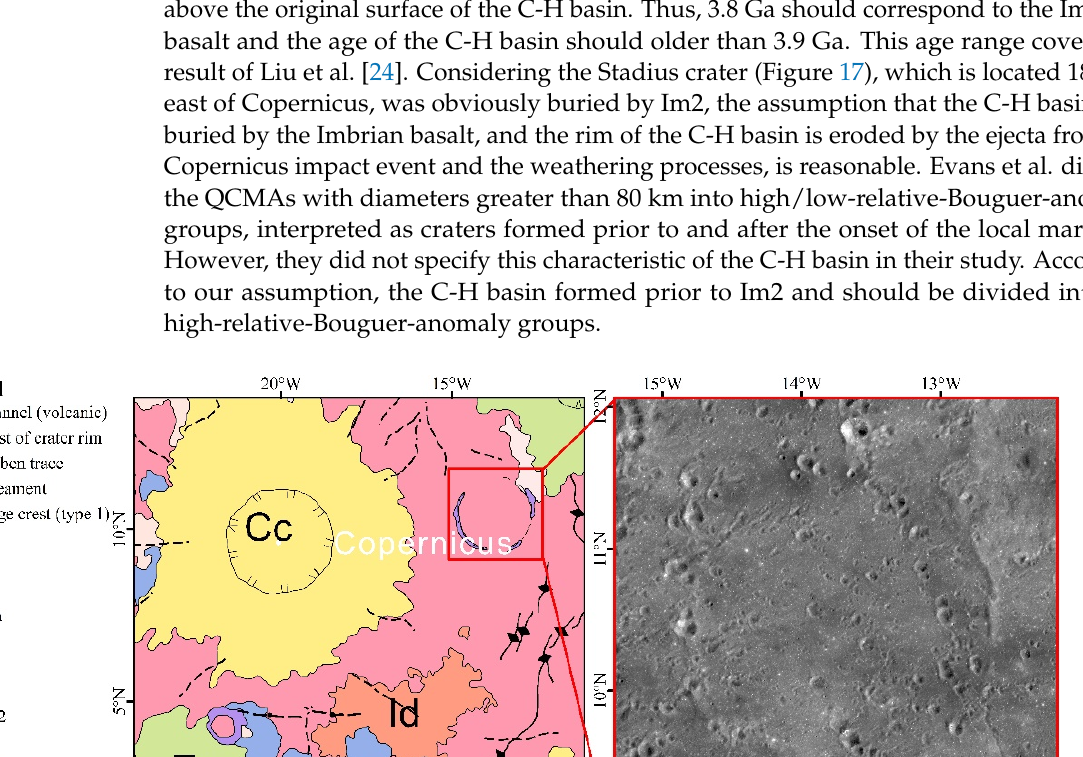
Figure 16. Two craters in the Sinus Aestuum- Ⅰ DMD. ( a ) Position of the craters on the Sinus Aes- tuum- Ⅰ DMD shown on the Kaguya TCortho Mosaic; ( b ) Crater A shown on the CE2 DOM G222; ( c ) Olivine map of Crater A; ( d ) Crater B shown on the CE2 DOM G222 and G223; ( e ) Olivine map of Crater B.